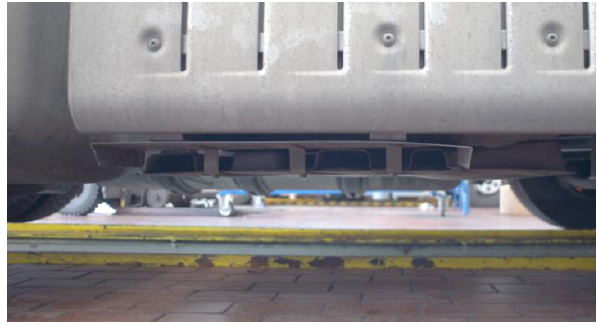
Fig. 3. View of the outlet of the exhaust system – Mercedes Actros truck